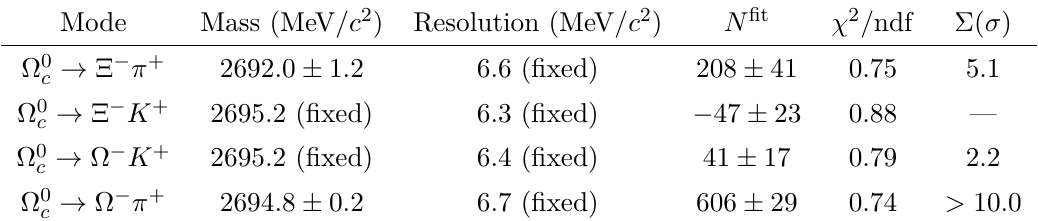
Table 2 . The results of fits to the data, where N fit represents the signal yield and Σ is the statistical significance. The uncertainties shown are statistical only.